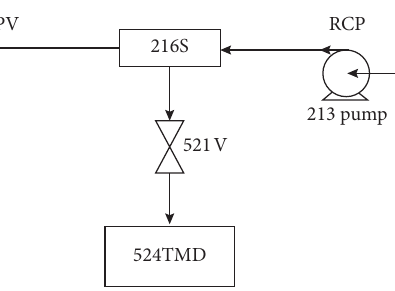
Figure 3: Small-break LOCA